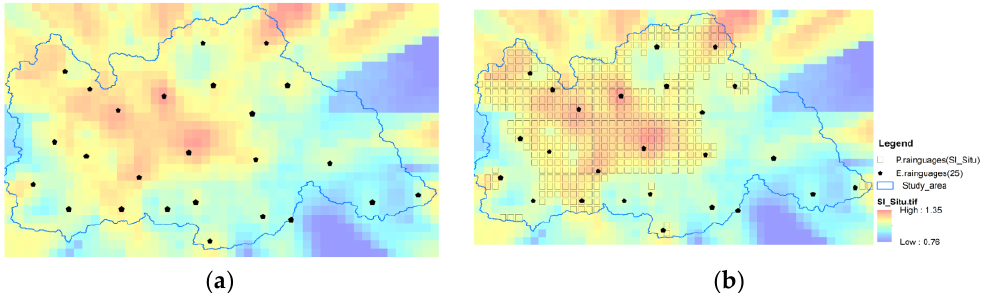
Figure 15. Screening based on 𝑆𝐼 𝑧 (𝑋) using measured data. ( a ) Spatial distribution of 𝑆𝐼 𝑧 (𝑋) based on measured data and ( b ) 0.5 quantile potential station distribution from quantile screening based on measured data.